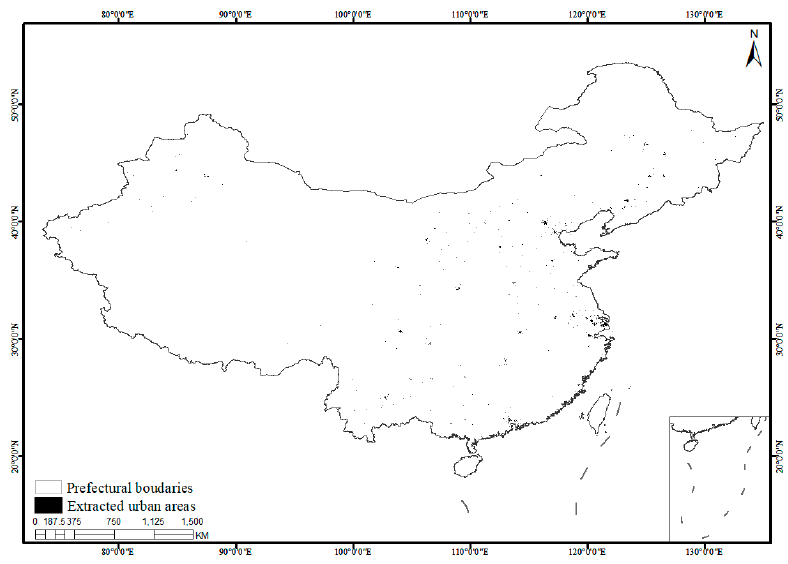
Figure 7. The urban areas in 2013 extracted from the NPP-VIIRS NTL data via the proposed